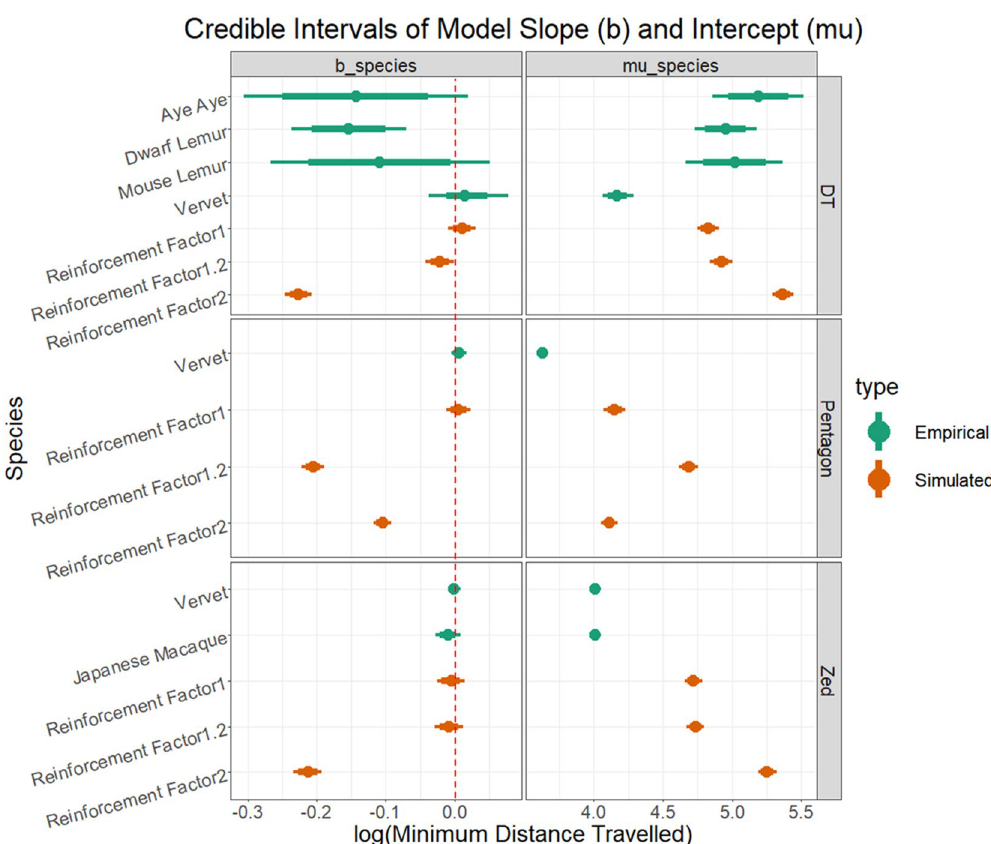
Figure 3. Posterior credible intervals for species-level slope and intercept parameters. 80% intervals (wide bars) and 95% intervals (thin bars) of posterior distributions of the model intercept for all species and simulated agents. The only species that show clear improvement with experience are dwarf lemurs in the Double Trapezoid (credible interval does not contain 0, dashed red line), though mouse lemurs and aye ayes also show some evidence of improvement in this array. Across arrays, vervets and Japanese macaques travel significantly less on initial trials than other species, and less than expected given the distance weighted location transitions of the Reinforcement Factor 1 agents. Created in R version